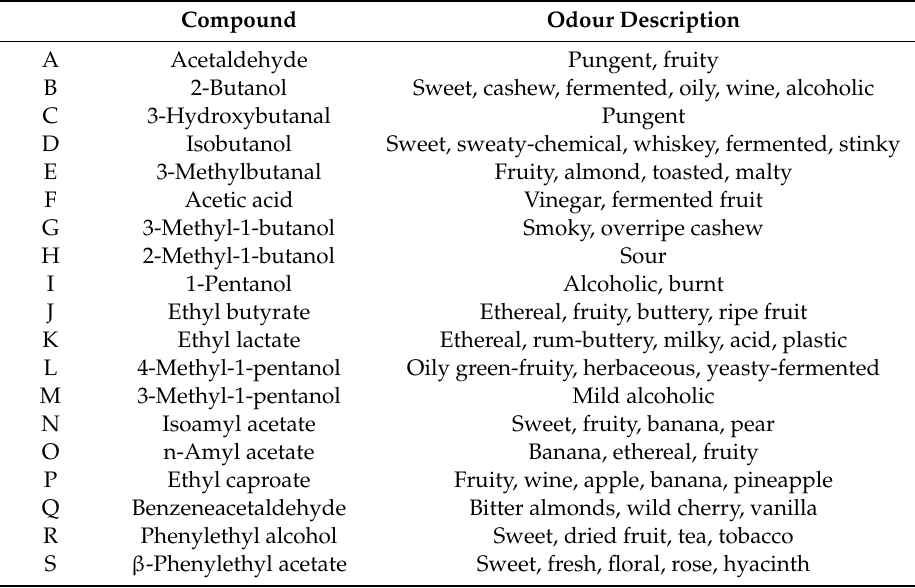
Table 4. Aroma compounds found in fermented cashew apple juice.